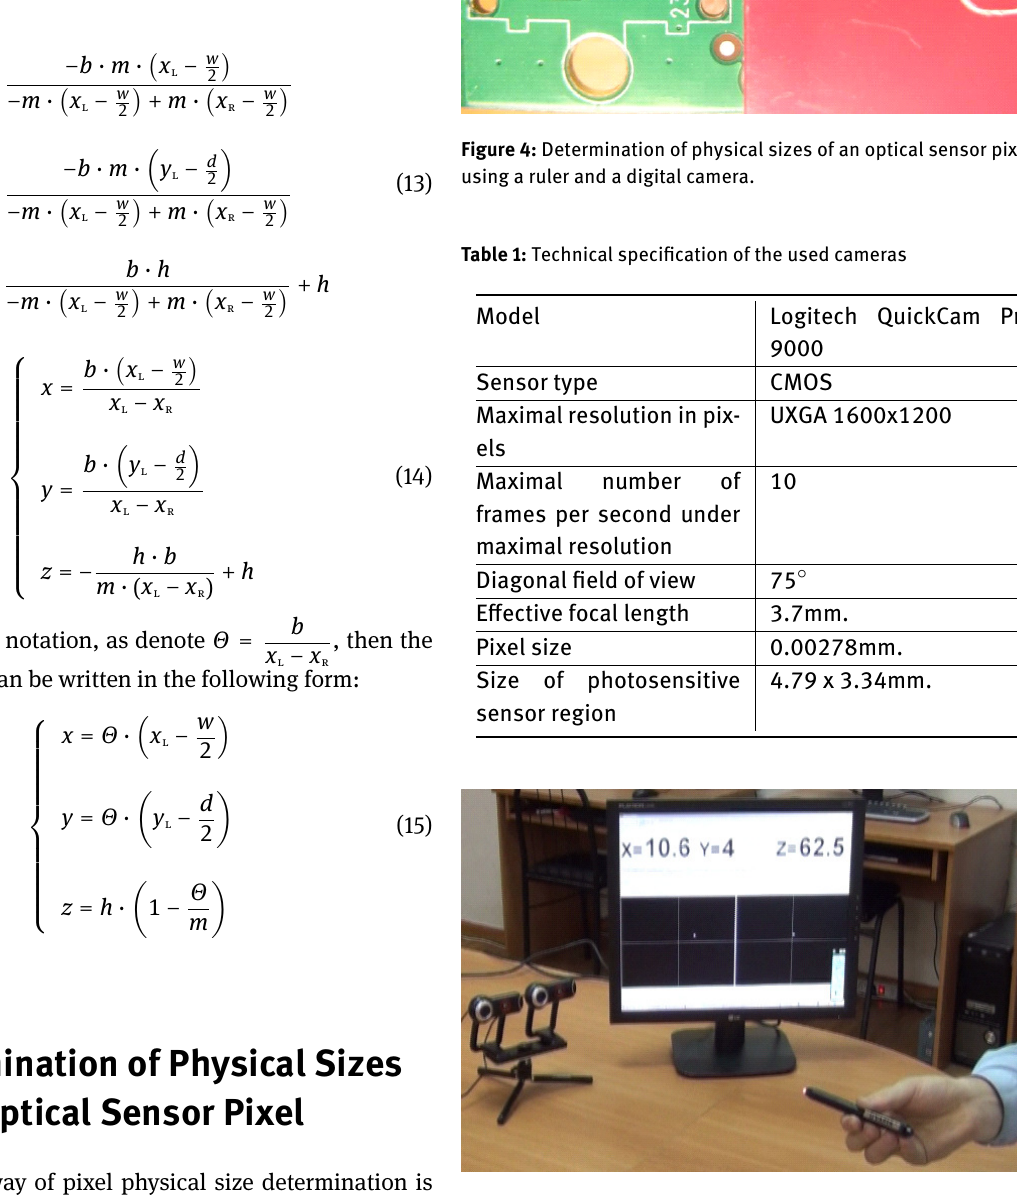
Figure 5: External view of the stereoscopic system consisting of two cameras with parallel optical axes mounted on the tripod and the video monitor used for displaying coordinate measurement results of the small shining lamp of the simple pocket